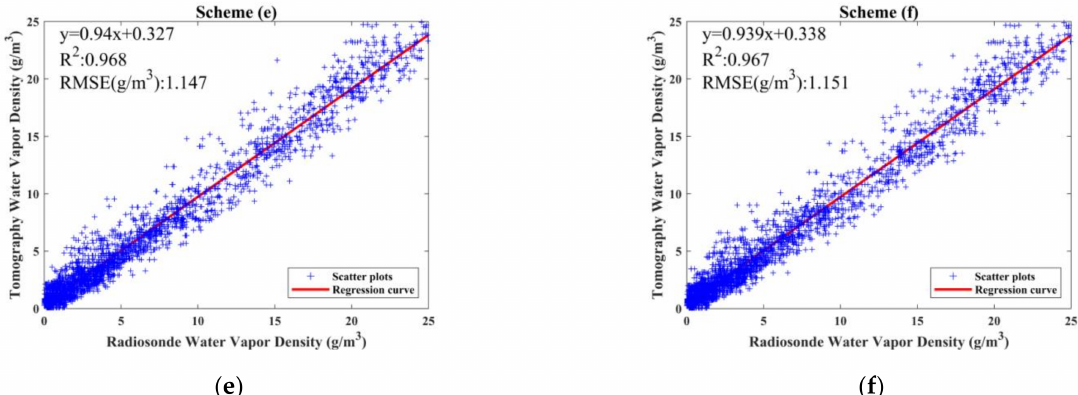
Figure 6. Scatter plots of water vapor density between radiosonde and tomography derived from the six stratification schemes, where ( a ) derived from uniform stratification; ( b – f ) derived from ANES with minimum height intervals of 350, 375, 400, 425 and 450 m, respectively.